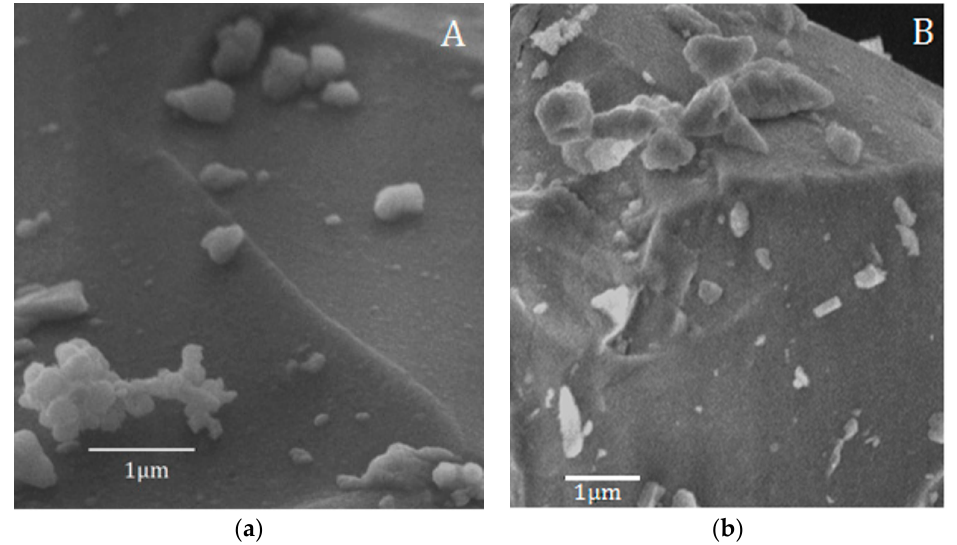
Figure 4. Scanning electron microscope (SEM) micrographs after immersion in SBF for 168 h (7 d): ( a ) BG; ( b ) BG-gly paste.